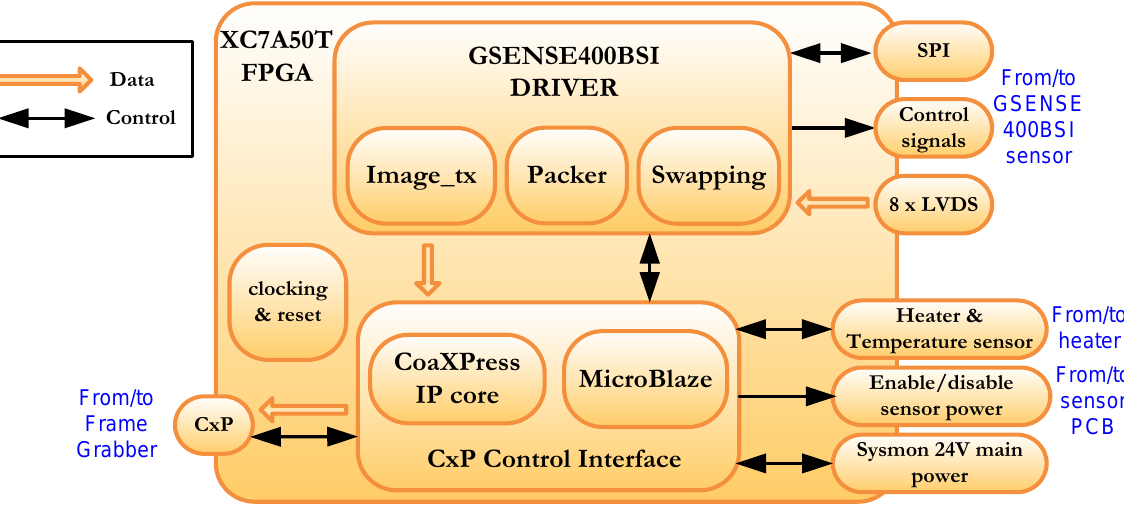
Figure 4. Camera FW device architecture.